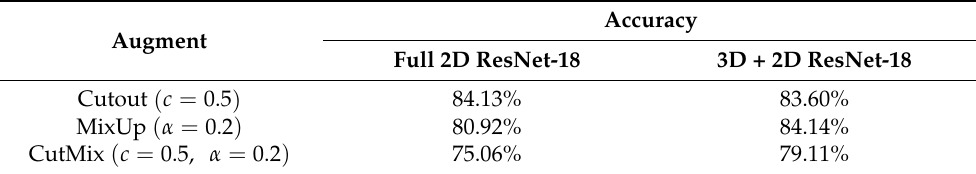
Table 4. Different data augment performance of the full 2D ResNet-18 and 3D + 2D ResNet-18 on LRW dataset. Results are reported in terms of RANK 1 identification accuracy (%).